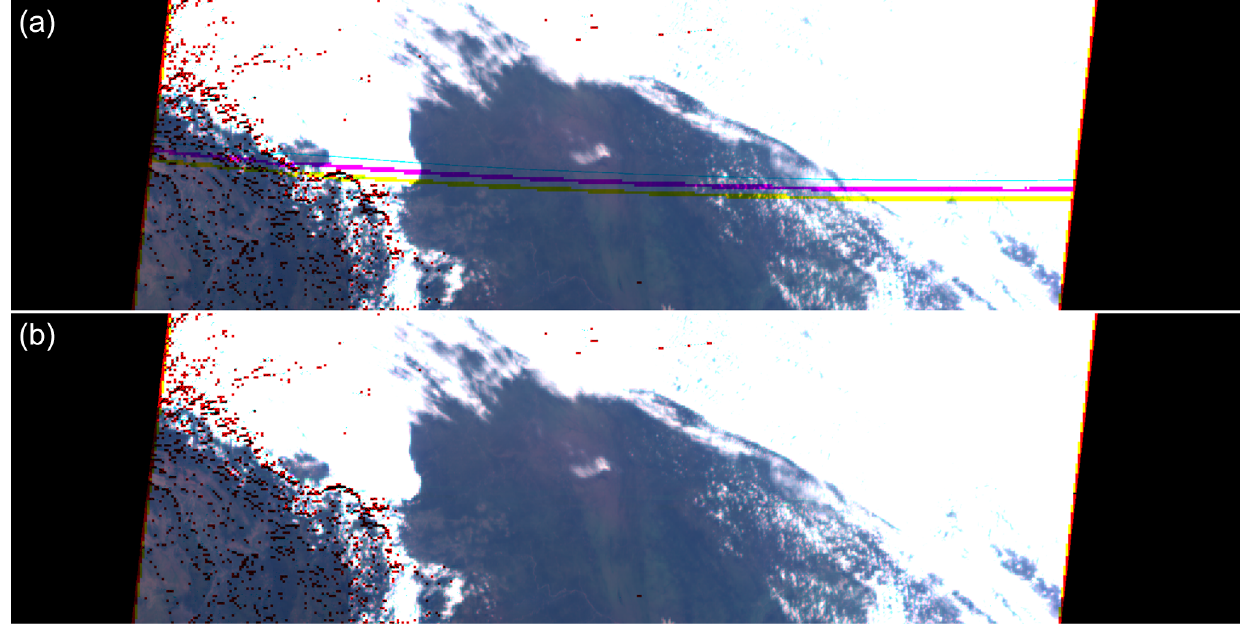
Figure 12. RGB maps of the three visible data channels for GM-P168-O065487-B110-CA (a) before and (b) after replacing the missing and poor data values with the best estimates computed as described above.